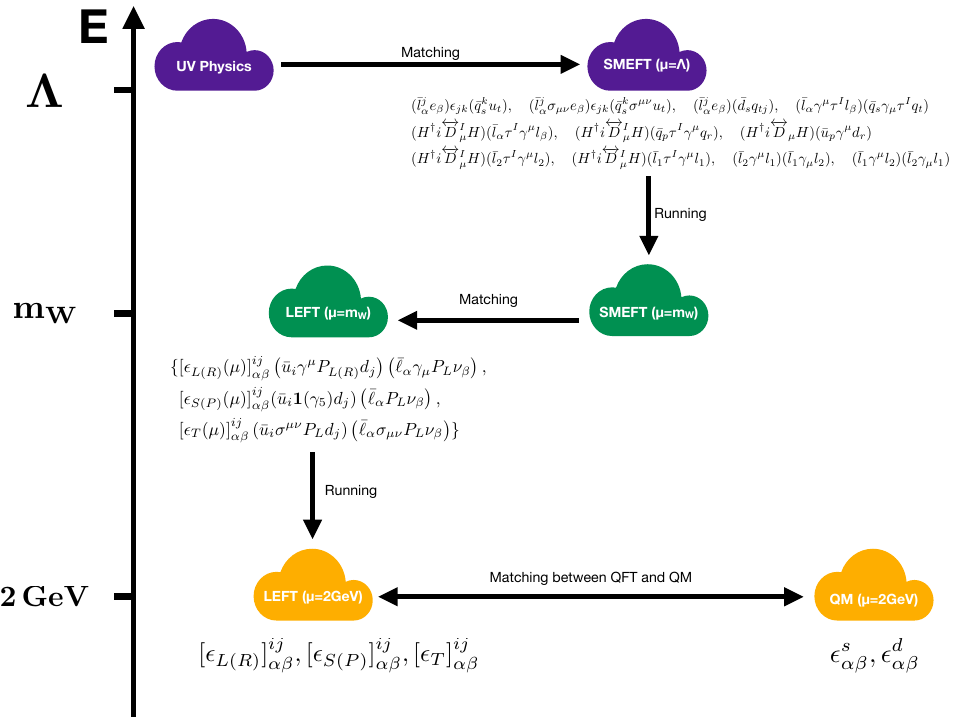
Figure 1 . Schematic description of relating the UV parameters to the neutrino NSI parameters. The vertical axis defines the scale where corresponding EFTs are present. The enumerated operators and/or Wilson coefficients under a certain EFT name at some energy scale µ are those relevant for our study in this work. See the main text for the